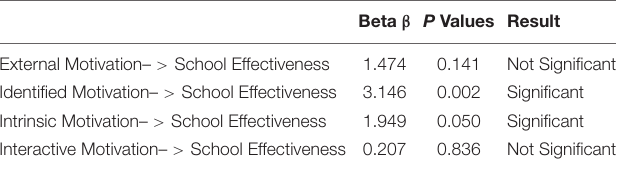
TABLE 6 | Assessment of significant